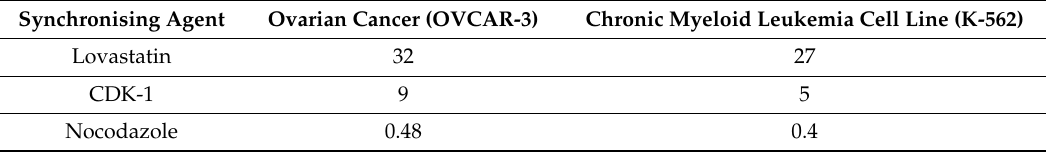
Table 1. Concentrations ( µ g / mL) of synchronizing